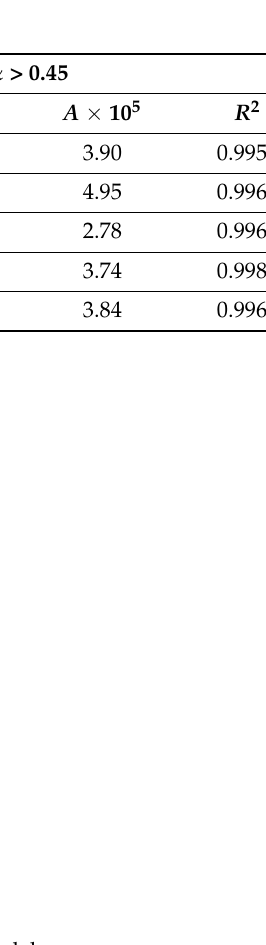
Figure 8. Model fitting results using the piecewise autocatalytic